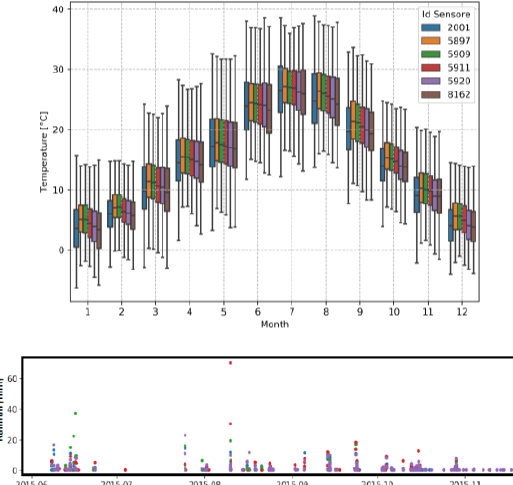
Figure 12. Temperature variability over the months (top).